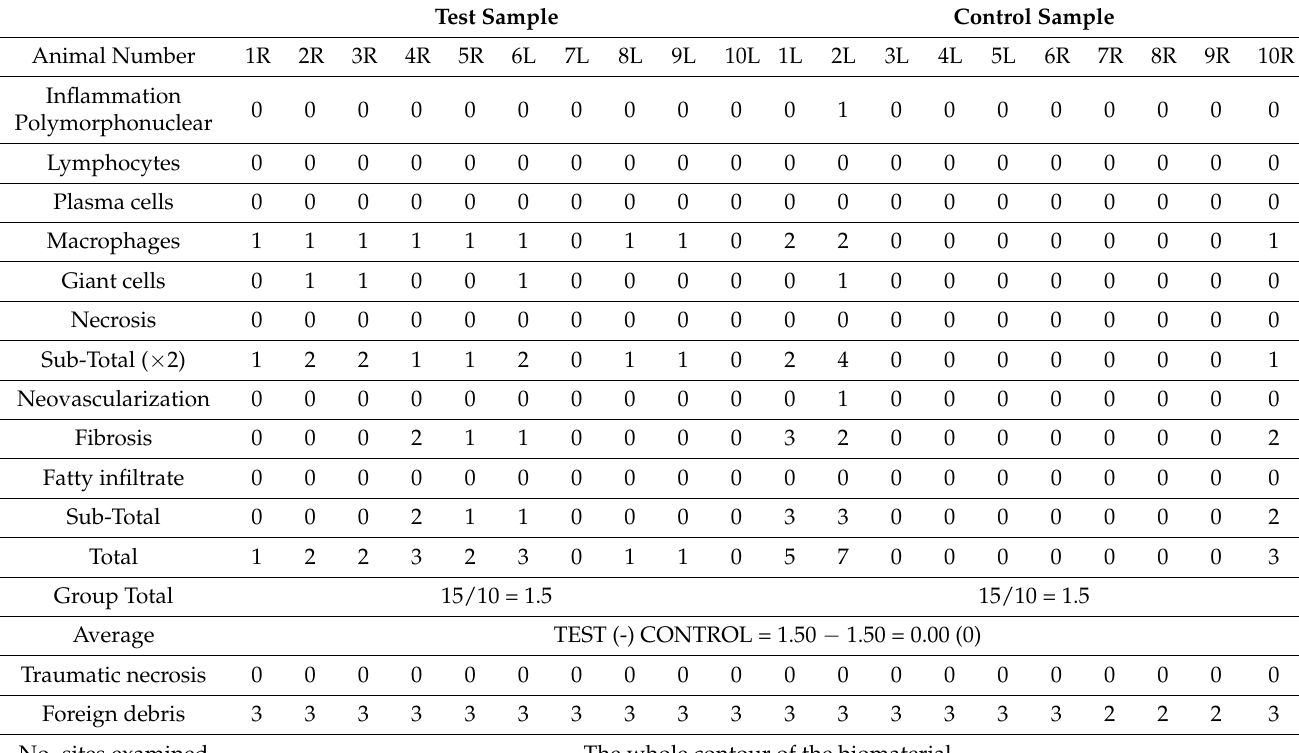
Table 1. Semi-quantitative histological evaluation at 12 weeks post implantation in the test group (shark tooth-derived bone graft) and in the control group (Bio-Oss ®